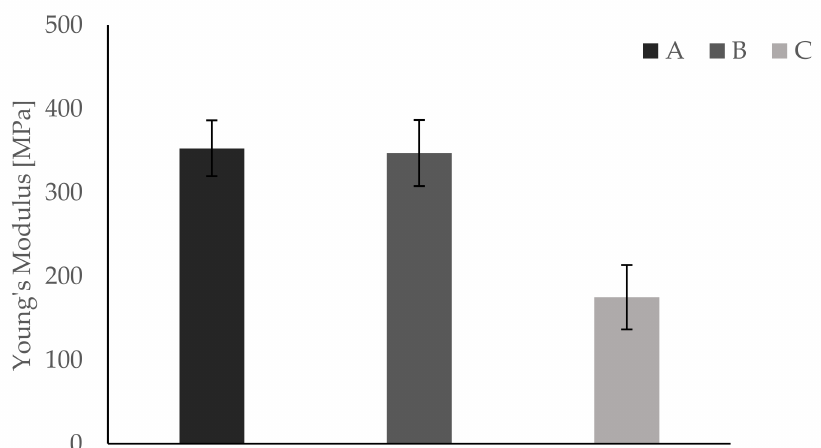
Figure 5. Bending tests show significantly higher values of Young’s modulus for groups A and B compared to group C.